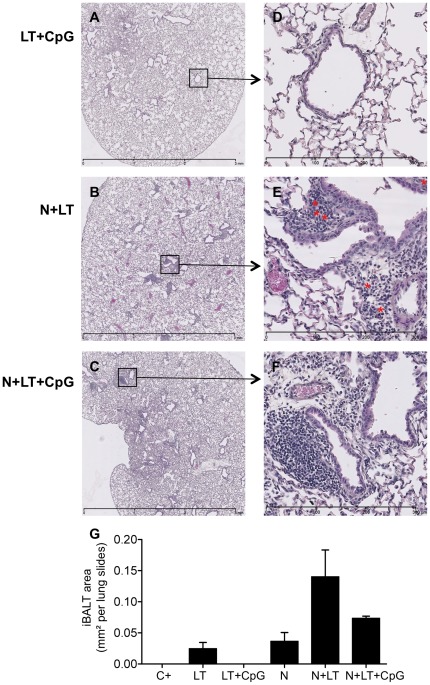
Neonatal nasal vaccination with N+LT or N+LT+CpG augmented cellular infiltration in lung tissue upon RSV challenge.Mice vaccinated as neonates as indicated or non vaccinated littermates were sacrificed 8 days after the hRSV-A2 challenge. Lung were dissected out, fixed, embedded in paraffin and sectioned at 5 µm. Lung sections were then stained with hematoxylin-eosin-saffron and photographed using a Nanozoomer (Hamamatsu). One representative section per group is shown (A–C: original magnification 2.5×) with red asterix figuring eosinophils in the enlarged selected area (D–F: enlargement 20×). (G) Total iBALT area was measured using the NDPview software (Hamamatsu) for one representative lung section of each mouse (n≥2 mice per group). Data are mean±SEM.